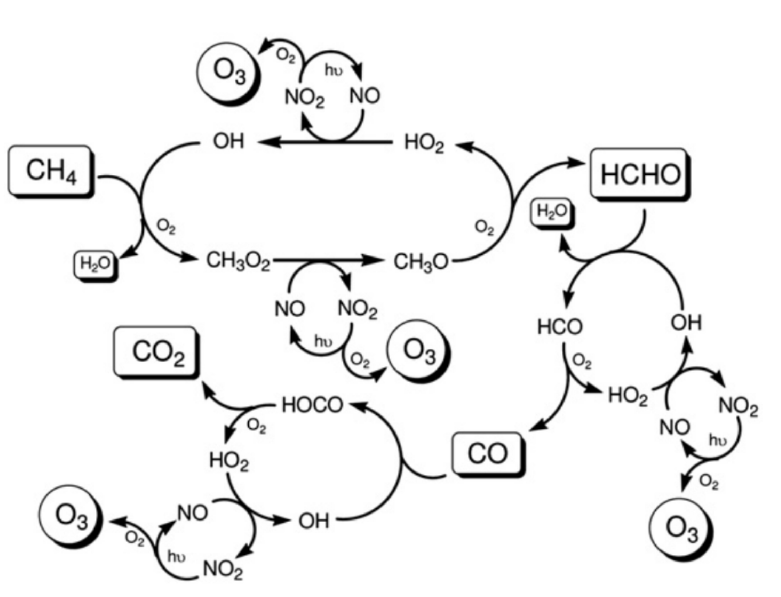
Figure 14. Schematic representation of the OH initiated, NO x -catalysed oxidation scheme for CO and CH 4 . Reprinted with permission from Jenkin et al. [135]. Copyright 2022,